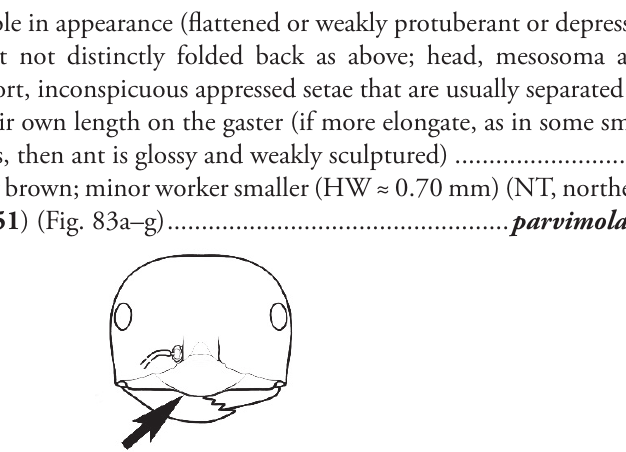
– Ant bicoloured, with tawny orange head, antennae and mesosoma, and black gaster and legs (legs have a bluish iridescent sheen); minor worker larger (HW ≈ 0.90 mm) (major worker unknown) (inland SA, WA; a few records only) ( JDM 1033) (Fig. 88a–d) ................................................................. xouthos 96 All workers with narrowly convex mesonotum; pronotum steeply (i.e., 60° >) inclined and flattened dorsally; minor workers with maximum of five mandibular teeth; major worker with all teeth in the same plane; bright red or reddish-orange ants with dark brown gaster (SE Australia) (Fig. 78a–g) ....